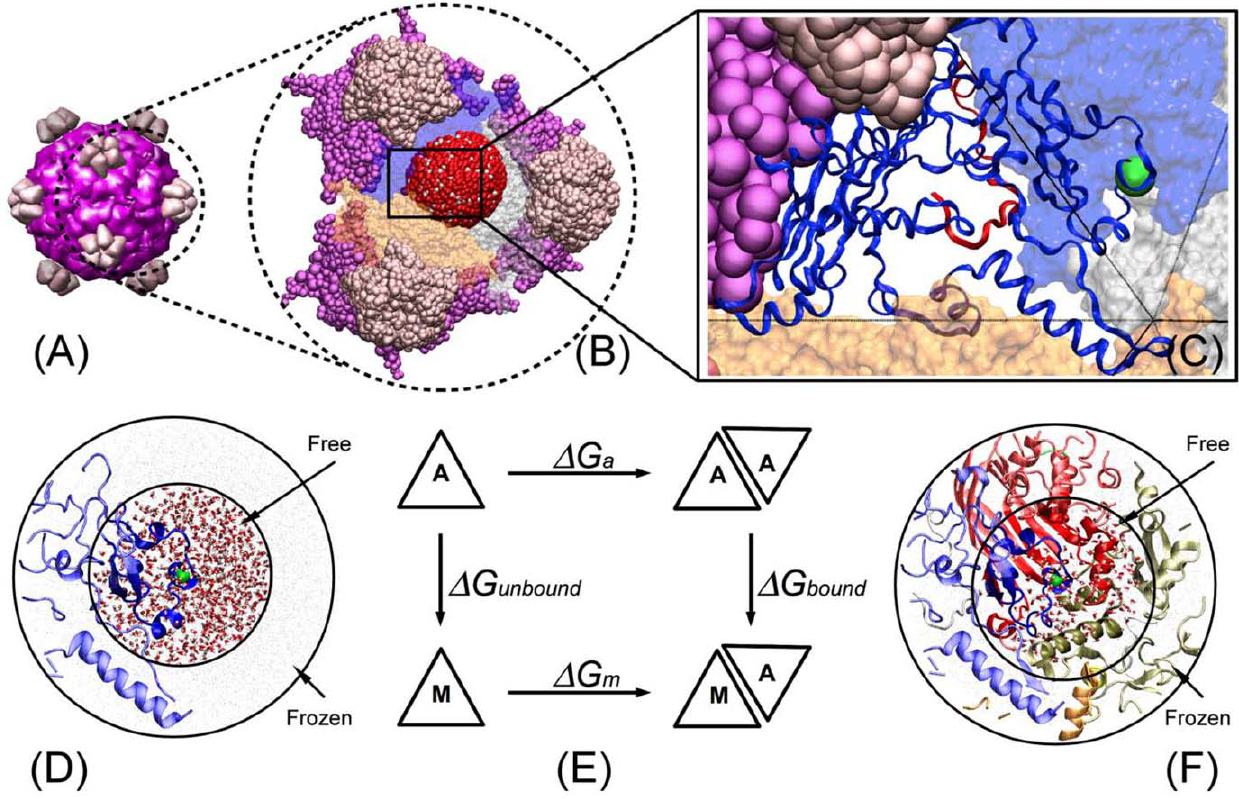
Figure 2. Interface mutations on the ID11 viral structure and design of the thermodynamic simulation model . (A) The mature virus capsid composed of 12 pentameric units. Each pentameric unit contains five identical copies of protein F (purple), and protein G (pink). (B) The simulation system containing three pentameric units. For each mutation a 35 A˚ radius sphere is defined to be centered on the mutation and is surrounded by water molecules and ions (red sphere). (C) Detailed view of one F protein and an example mutation (F314). (D) Representation of the left vertical path in thermodynamic cycle. A single protein in water is simulated. (E) Thermodynamic cycle. The horizontal paths are binding affinities that can be measured experimentally. In this study, the vertical paths are computed by thermodynamic integration. Because the binding affinity is a state function, the two vertical paths can be used to determine the relative binding affinity, i.e., DD G = D G bound - D G unbound . (F) Representation of the right vertical path in thermodynamic